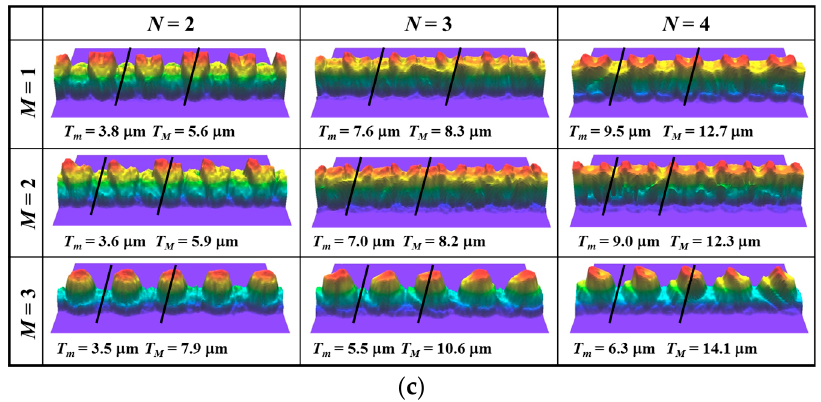
Figure 16. Morphologies of inkjet-printed lines on S 50 substrate for different numbers of printings ( N ) at 75 °C substrate temperature when using interlacing printing procedure: ( a ) top view at N = 1 ( b ) top views and ( c ) oblique views at N = 2~4.